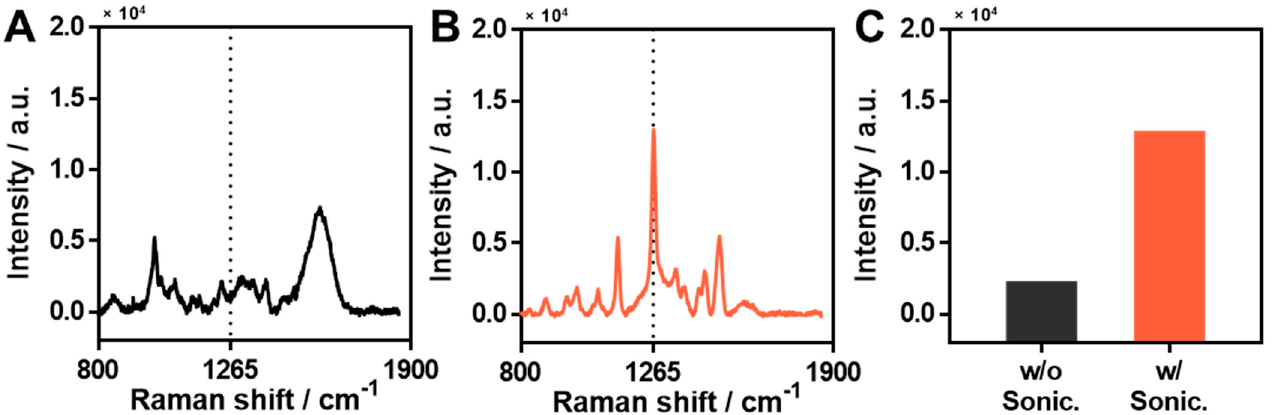
Figure 2. Optimization of sample preparation: sonication. ( A ) SERS spectrum of un-sonicated CPF solution on the Ag-NG. ( B ) SERS spectrum of sonicated CPF solution on the Ag-NG. ( C ) Comparison of SERS intensity at 1265 cm − 1 according to sonication. CPF was dissolved in methanol and the solution was sonicated for 30 s. The sonicated and un-sonicated CPF solutions (1 mM) were treated equally on the Ag-NG.